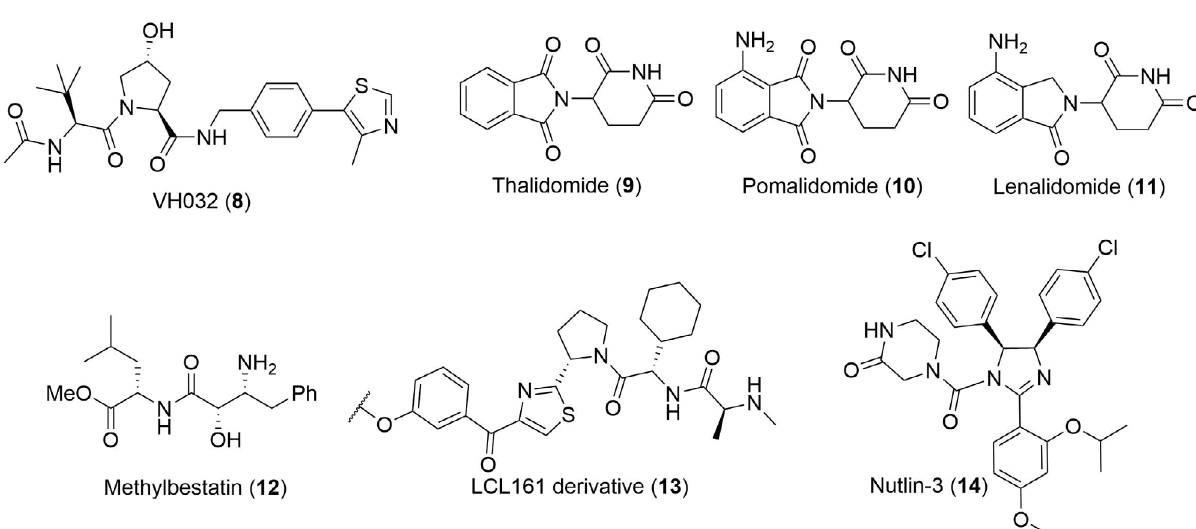
Figure 4. Commonly used anchor ligands. Structure of the high-affinity ligand VH032 (8) commonly used to recruit VHL. Structures of thalidomide (9) and its analogues pomalidomide (10) and lenalidomide (11), which recruit CRBN. Methylbestatin (12) and a higher-affinity derivative of LCL161 (13) are most commonly used to target cIAP. Nutlin-3 (14) has been used to target